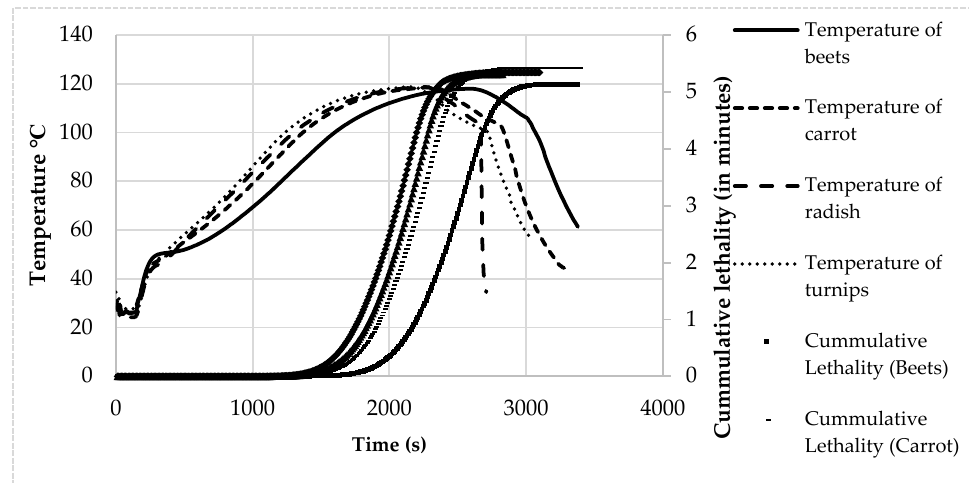
Figure 1. Temperature and lethality values obtained for processed vegetable pieces (non-acidified) during the cooking at 120 °C [Fo (121.1 °C) values].